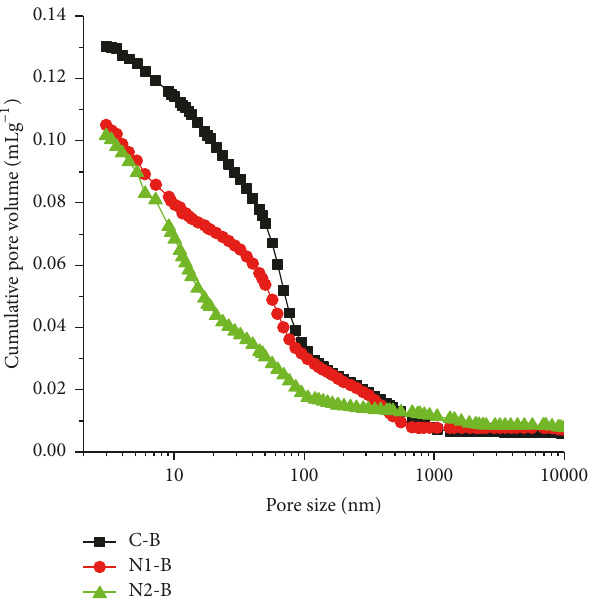
Figure 13: Pore structures of the standard-cured hardened paste with W/B of 0.32 at the age of 90